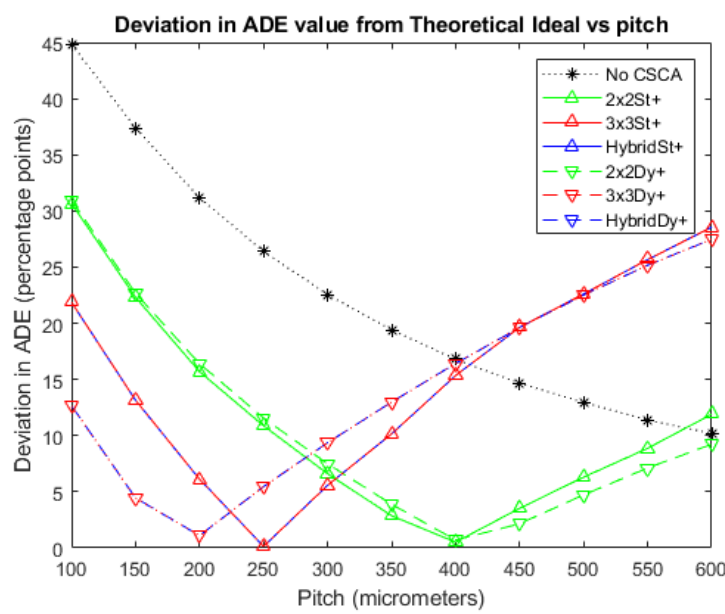
Figure 7. A plot of the difference between each CSCA and the theoretical ADE proposed earlier at an incident photon flux of 10 7 photons mm −2 s −1 . The difference is taken directly from the data for Figure 4 and so is expressed as percentage points. Again, the case where no CSCA is applied is presented for comparison.